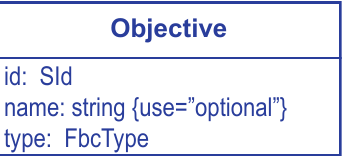
Figure 4: A UML representation of the Flux Balance Constraints package Objective class. See Section 1.4 for conven- tions related to this figure.